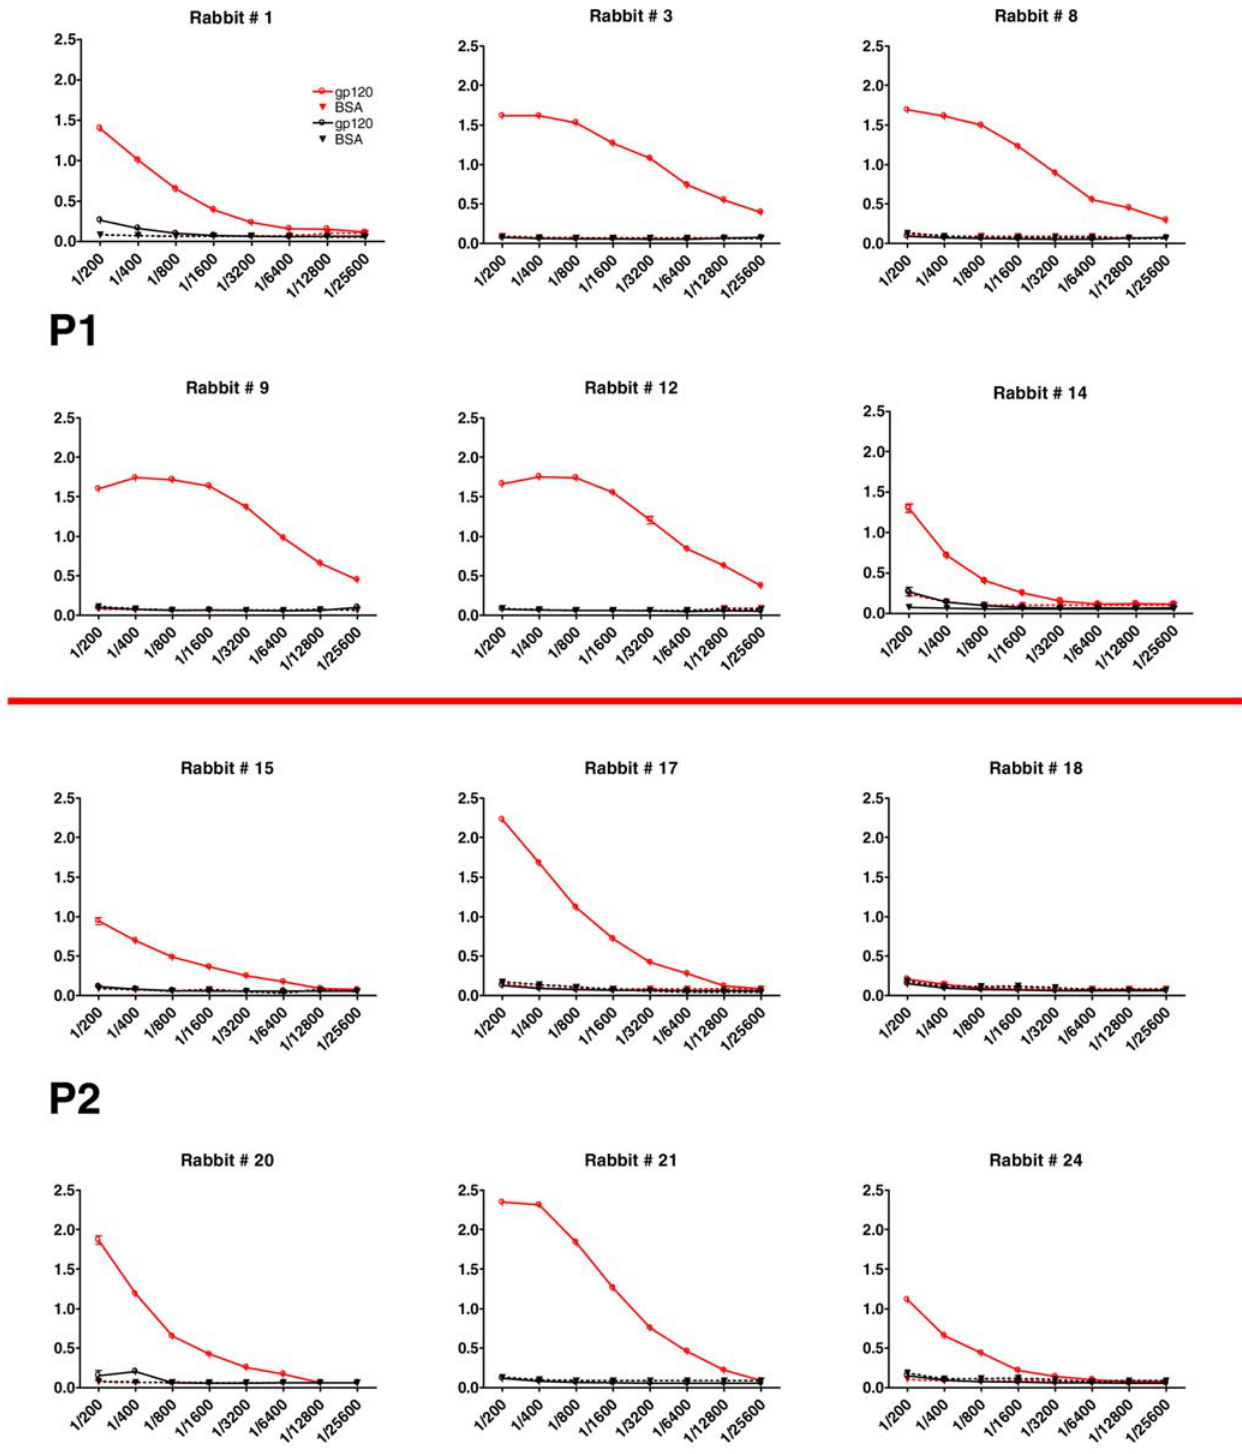
Figure 2. Evaluation of P1 and P2-induced antibody response in rabbits and of its neutralizing activity in an Env-based pseudovirus assay. ELISA titers of preimmune (black) and immune (red) rabbits’ sera on gp120 IIIB (continuous line) and BSA (dotted line) after three immunizations with the reported antigens. Data regarding the gp120 (positive control) and the J1 (negative control) groups are not reported, but for all animals the titers were . 1:12800 and , 1:25, respectively. Moreover, among the animals immunized with the mouse mAbs, no difference was evidenced in terms of response elicited against the specific molecule used for the immunizations (data not shown).